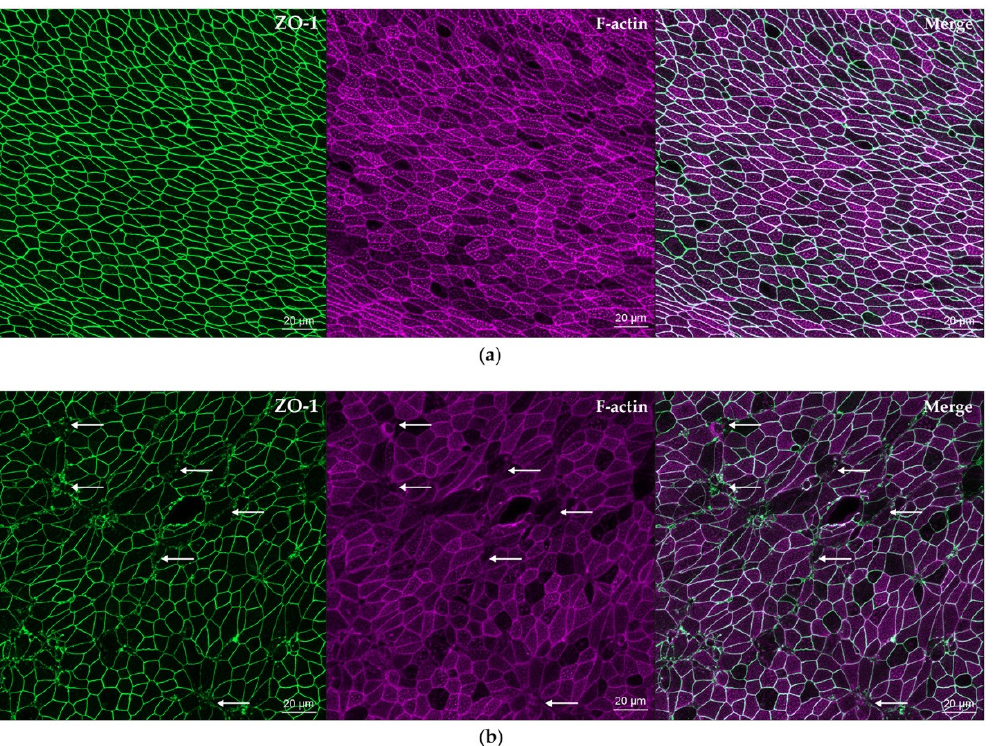
Figure 4. Influenza A / H1N1pdm09 damages epithelial tight junctions and the cytoskeleton of wdNHBE cells. Cells grown on transwells were ( a ) inoculated with ALI media (mock) or with ( b ) IAV H1N1pdm09 (MOI 1). At 30 h postinfection, cells were fixed in 4% PFA and stained with ZO-1 (green) and phalloidin (F-actin, pink). ( a ) While ZO-1 formed intact perijunctional belts around each cell in the mock treated cells, ( b ) ZO-1 was disrupted in IAV-infected cells (arrows, selected cells shown). Similarly, F-actin filaments were intact in mock cells ( a ), but ( b ) disrupted by IAV (arrows, selected cells shown). The colocalization of the ZO-1 perijunctional belt and its attachment to the cytoskeleton are shown by the Merge for ( a ) mock and ( b ) IAV-infected cells. Maximum intensity projections of en face Z-stacks, 19 slices (9 µ m) imaged using a 40x oil immersion objective are representative of three independent experiments. A 20 µ m scale bar indicates image magnification.